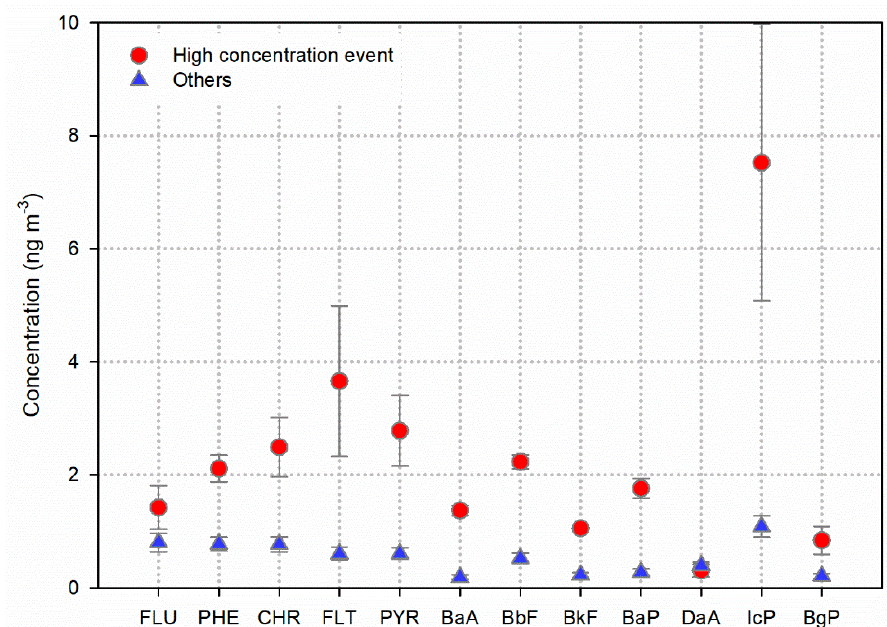
Figure 5. Increment of PAH species for the top 10% of ∑ PAHs samples. Note that the error bars indicate one standard error.